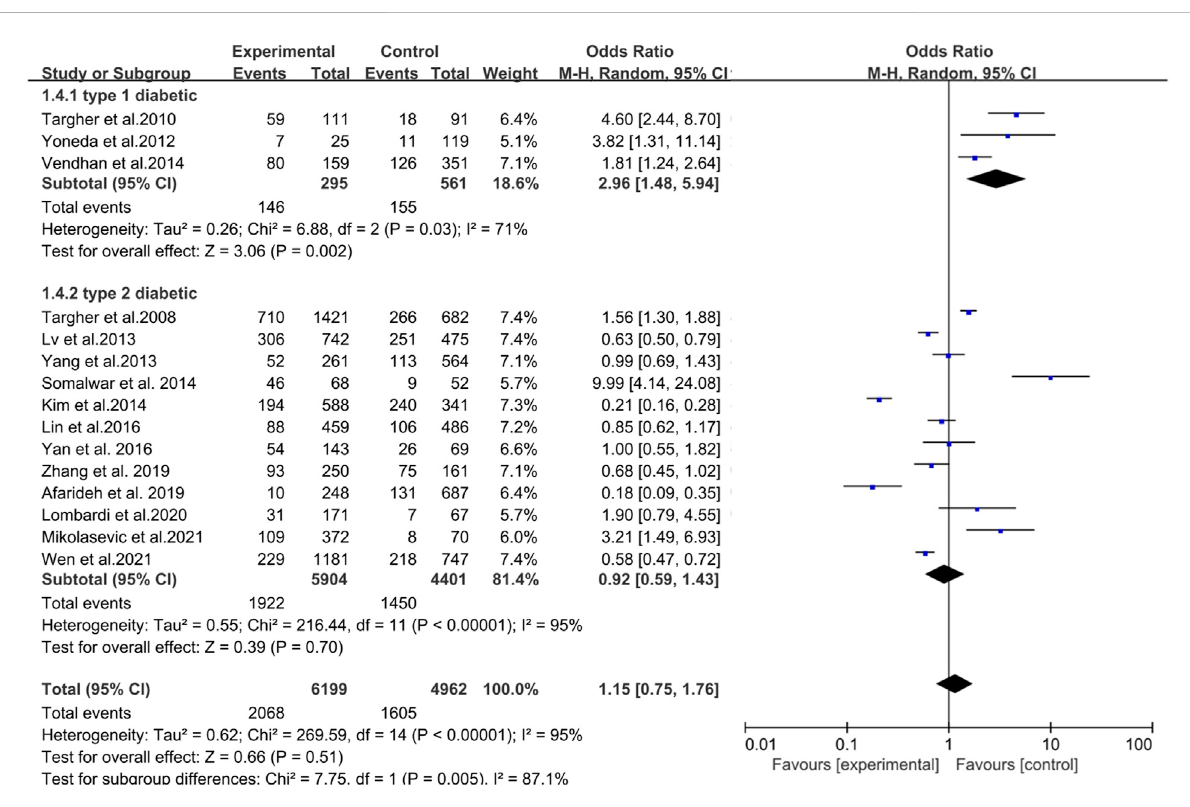
FIGURE 4 Meta-analysis of the association between nonalcoholic fatty liver disease and the risk of diabetic retinopathy in patients with different types of